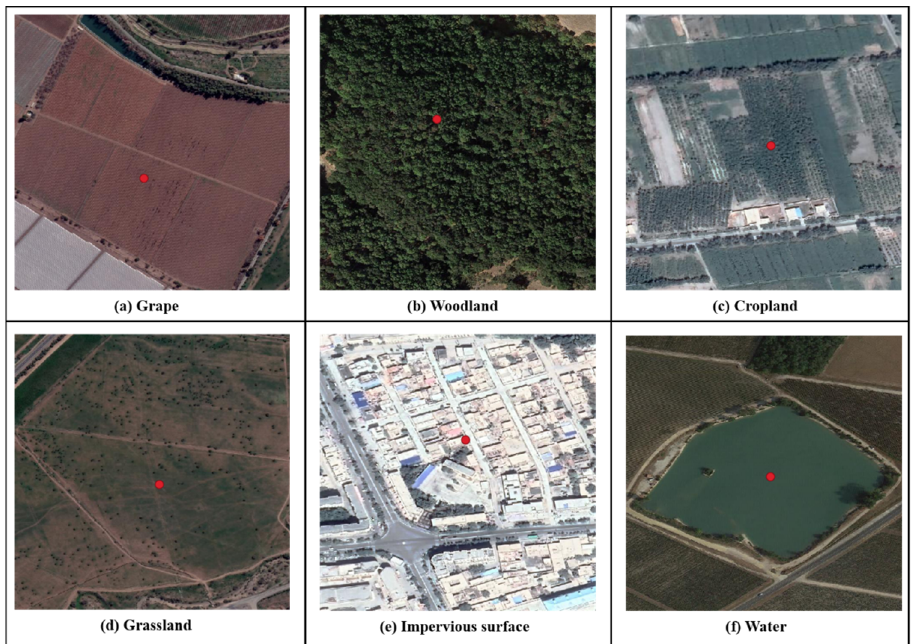
Figure 2. VHR images of ( a ) vineyards and other landscapes ( b ) Woodland, ( c ) Cropland, ( d ) Grassland, ( e ) Impervious surface and ( f ) Water. Table 3. Different levels of spatial resolution of the images used for